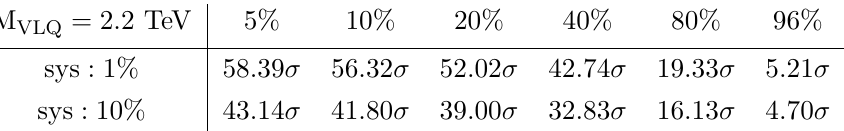
Table 10. Asimov significance, Z A , for VLQ pair-production. The last six columns show the Asimov significance assuming a suppression of 5% to 96% in the signal cross section coming from unaccounted effects. In the first row a systematic uncertainty in Z of 1% is considered, whereas in A the second row we assume a systematic uncertainty of 10%. We consider an integrated luminosity of 1 corresponding the acquired data after the LHC L = 139 fb −